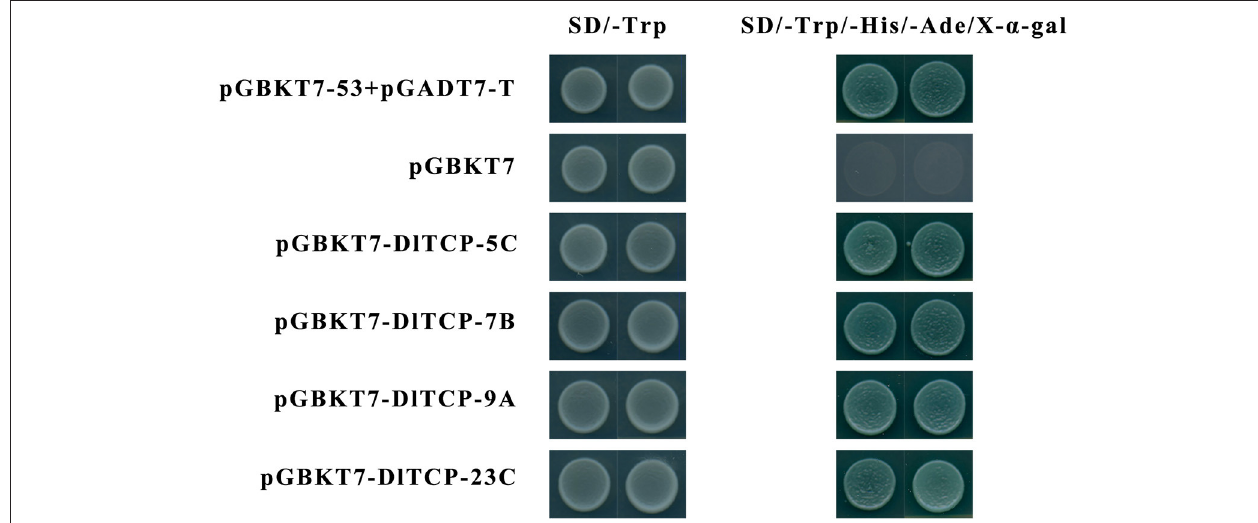
FIGURE 10 | Transactivational analyses of DlTCP proteins in yeast. The positive control pGBKT7-p53 + pGADT7-T, negative control pGBKT7 empty plasmid, and four candidate pGBKT7-DlTCPs plasmids were transformed into yeast AH109, and the strains were further cultured on the yeast medium of SD-Trp and